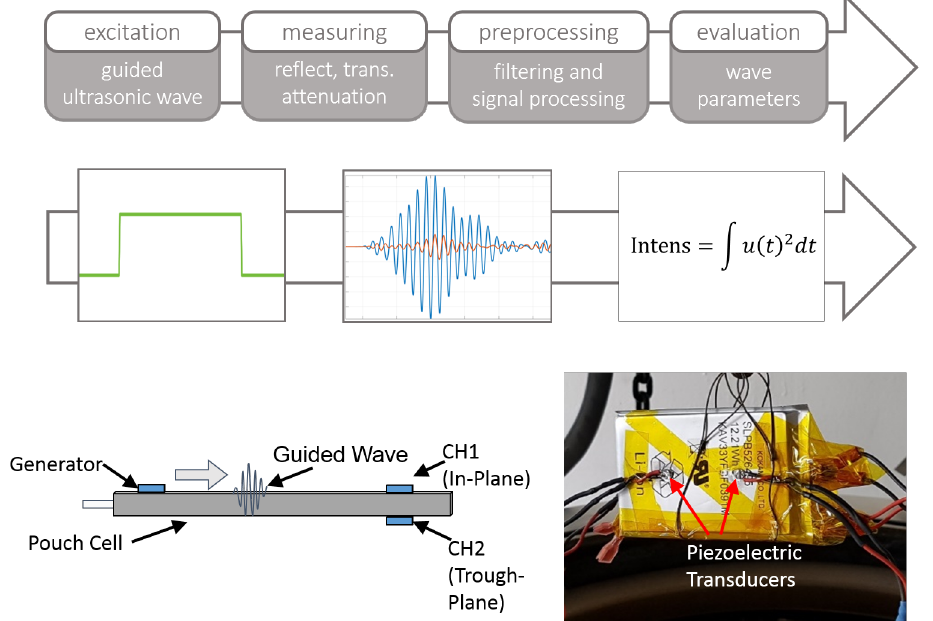
Figure 4. Top: Measurement concept of the used Ultrasonic technique. Bottom: Schematic overview of applied sensors and photograph of the prepared